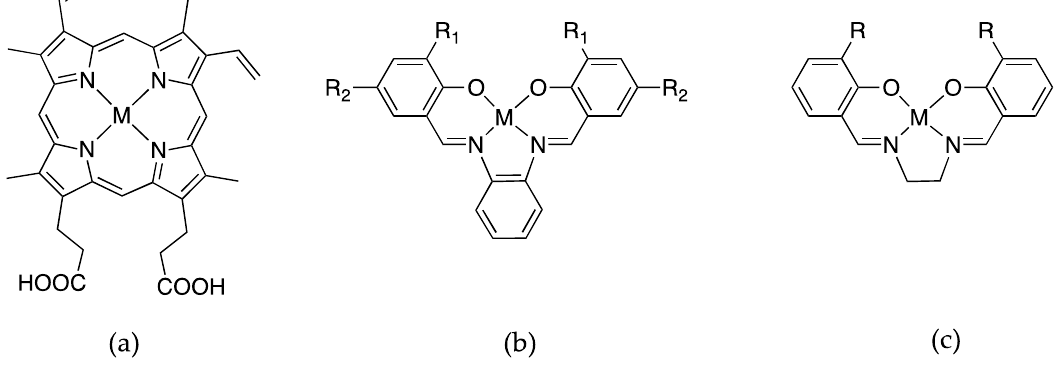
Figure 6. Schiff-base metal complexes that are substituted into apomyoglobin, where M = Fe, Mn, Cr, or Co. ( a ) protoporphyrin IX; ( b ) salophen, where R 1 = R 2 = H or R 1 = Me and R 2 = H or R 1 =H and R 2 = t Bu and ( c ) salen where R = Me, Et, or n -Pr.